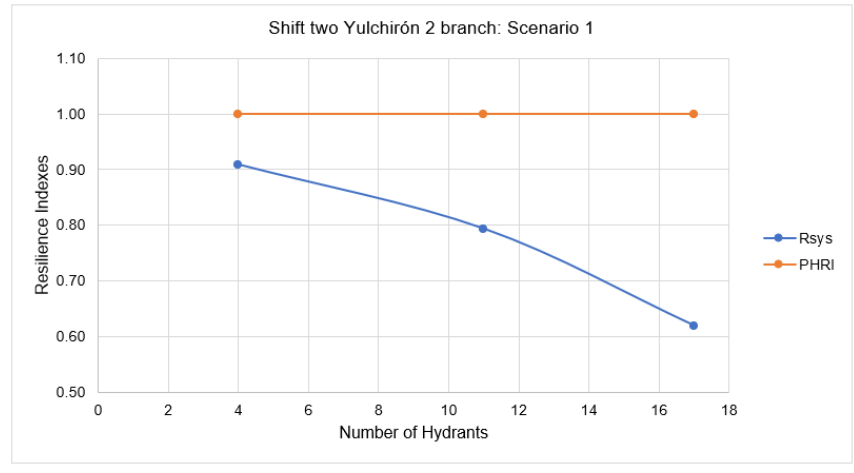
Figure 15. “Rsys” and “PHRI” results, for scenario 1 in shifts.